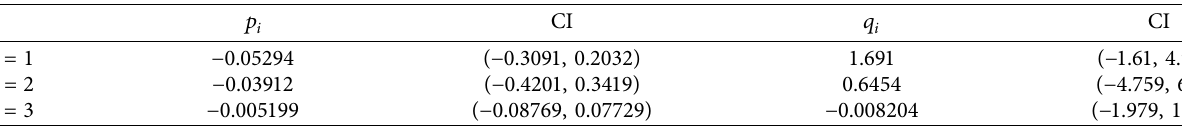
Table 11: HoF vs. AZI.